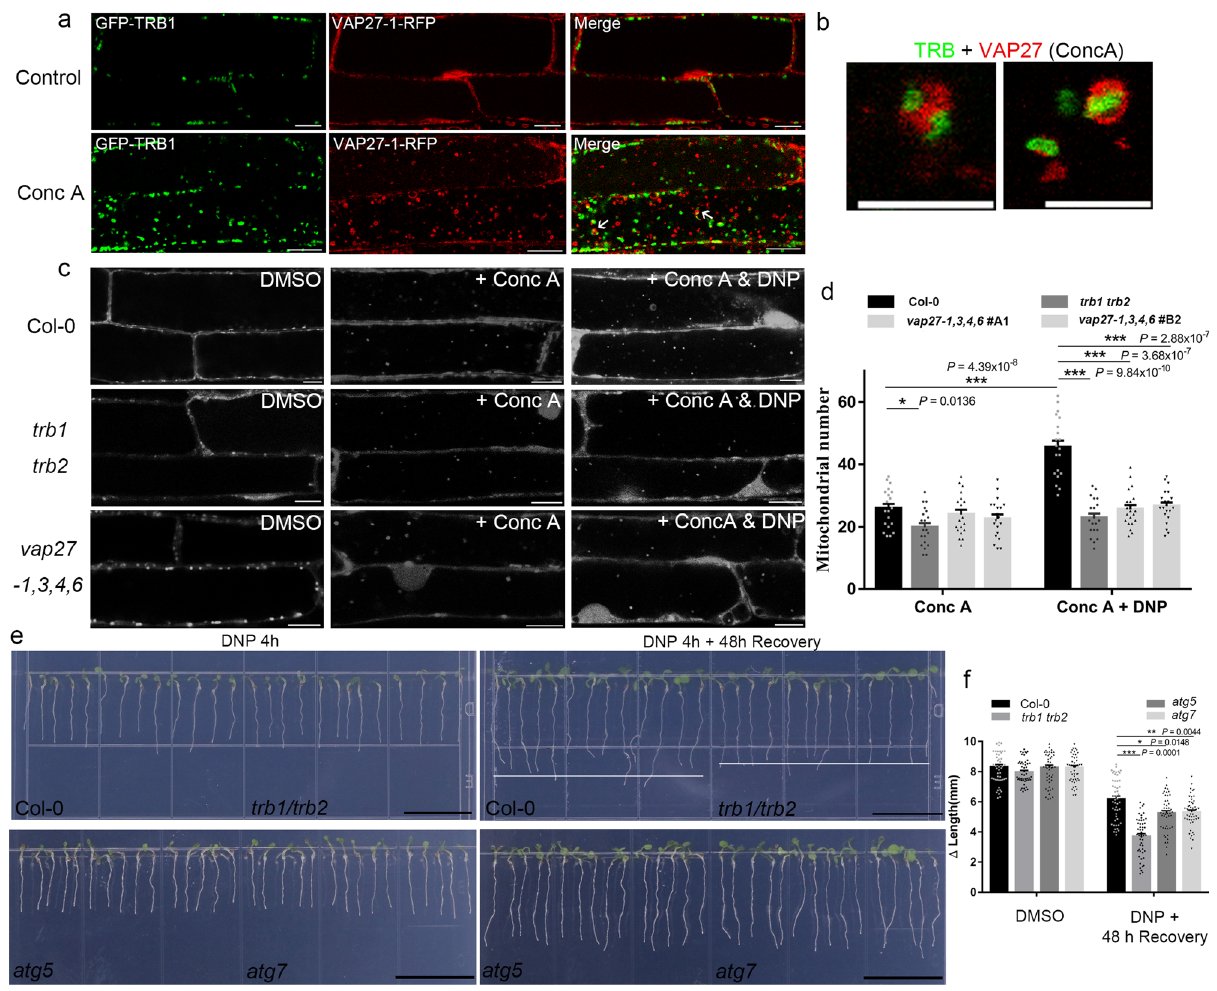
Fig. 7 | Mitochondrial stress-induced mitophagy is inhibited in the trb1/trb2 mutants. a Transgenic Arabidopsis expressing GFP-TRB1 and VAP27-1-RFP were treated with Conc A. The majority of TRB1-labelled mitochondria are found in contact with VAP27-labelled ER membrane inside the vacuole, suggesting that these two structures are internalised together. b High magni fi cation images of ( a ). c , d Arabidopsisplants(Col-0; trb1/trb2 ; vap27-1,3,4,6 )stablyexpressingMito- mCherry were treated with DNP and Conc A to study the activity of mitophagy. Under non-stressed conditions, the mitochondrial turnover rate is similar in all plants analyzed. However, the number of vacuole-accumulated mitochondria is signi fi cantlyreducedinboththe trb1/trb2 andthe vap27-1,3,4,6 (twoindependent lines,A1andB2)mutantstreatedwithDNP,suggestingthataninterruptionofER- Mitochondrial interaction affects mitochondrial turnover following